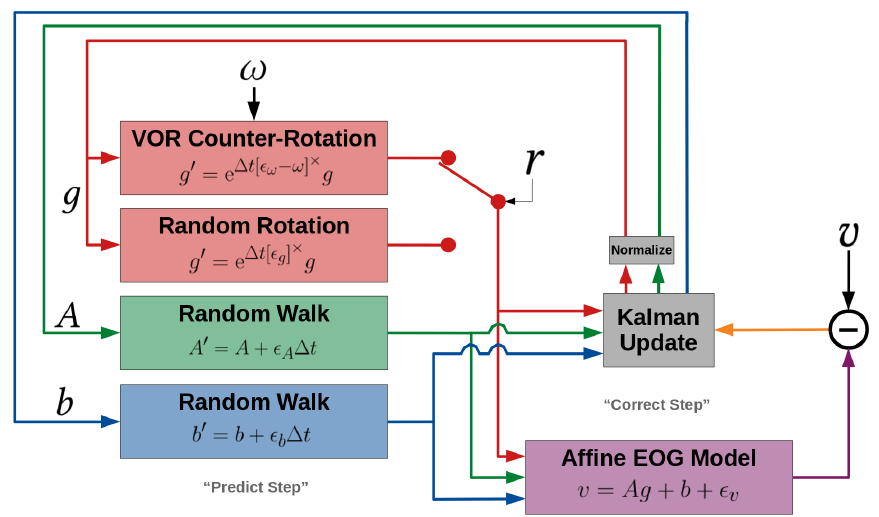
Figure 3: Block diagram expressing the signal path for an extended Kalman filter applied to our model. The ϵ ∗ are Gaussian white-noise variables introduced to express the corresponding covariances C ∗ algebraically in state-space